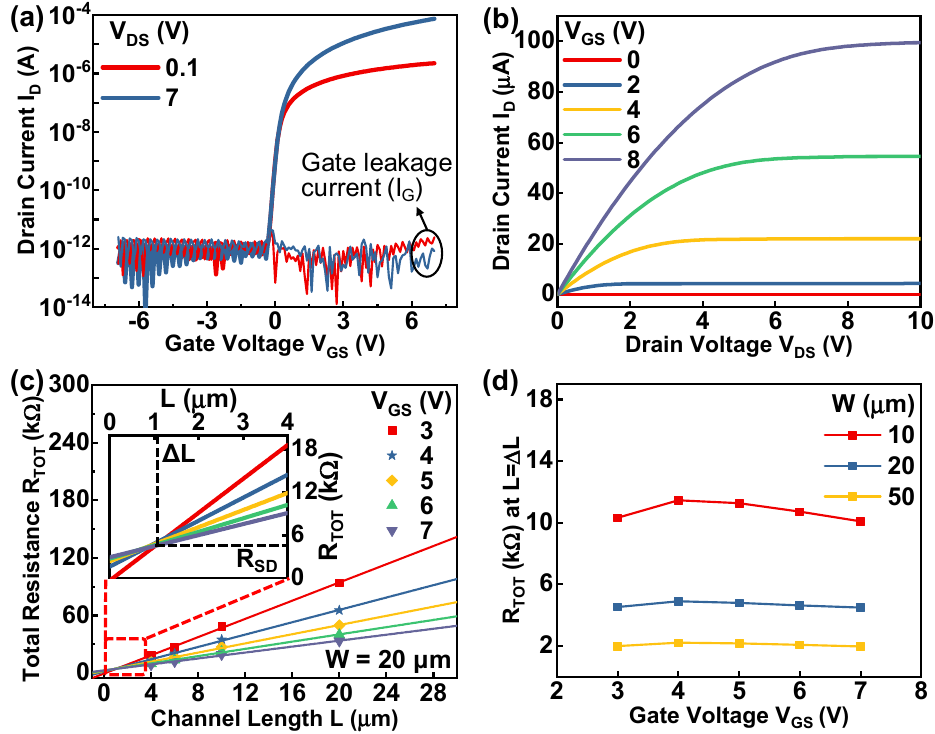
Figure 2. ( a ) Transfer characteristics and ( b ) output characteristics of a fabricated device. ( c ) Variation in the total resistance ( R TOT ) as a function of channel length (channel width is fixed at 20 µ m) at various gate voltages. ( d ) R TOT values at L = ∆ L of the TFTs with different channel widths extracted using the transmission line method.